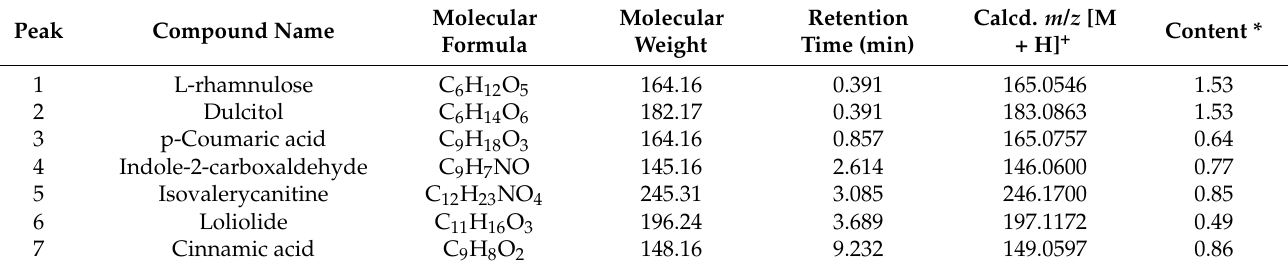
Table 3. Chemical characterization of S. thunbergii extract by